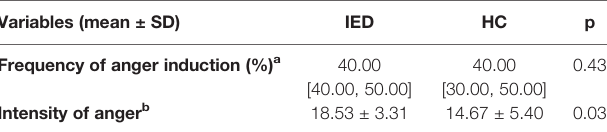
TABLE 2 | The result of anger